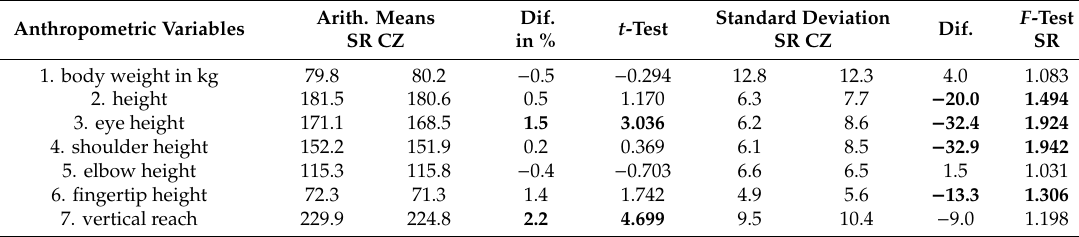
Table 4. Basic characteristics of anthropometric variables and their variation in the Slovak and Czech male population in the year